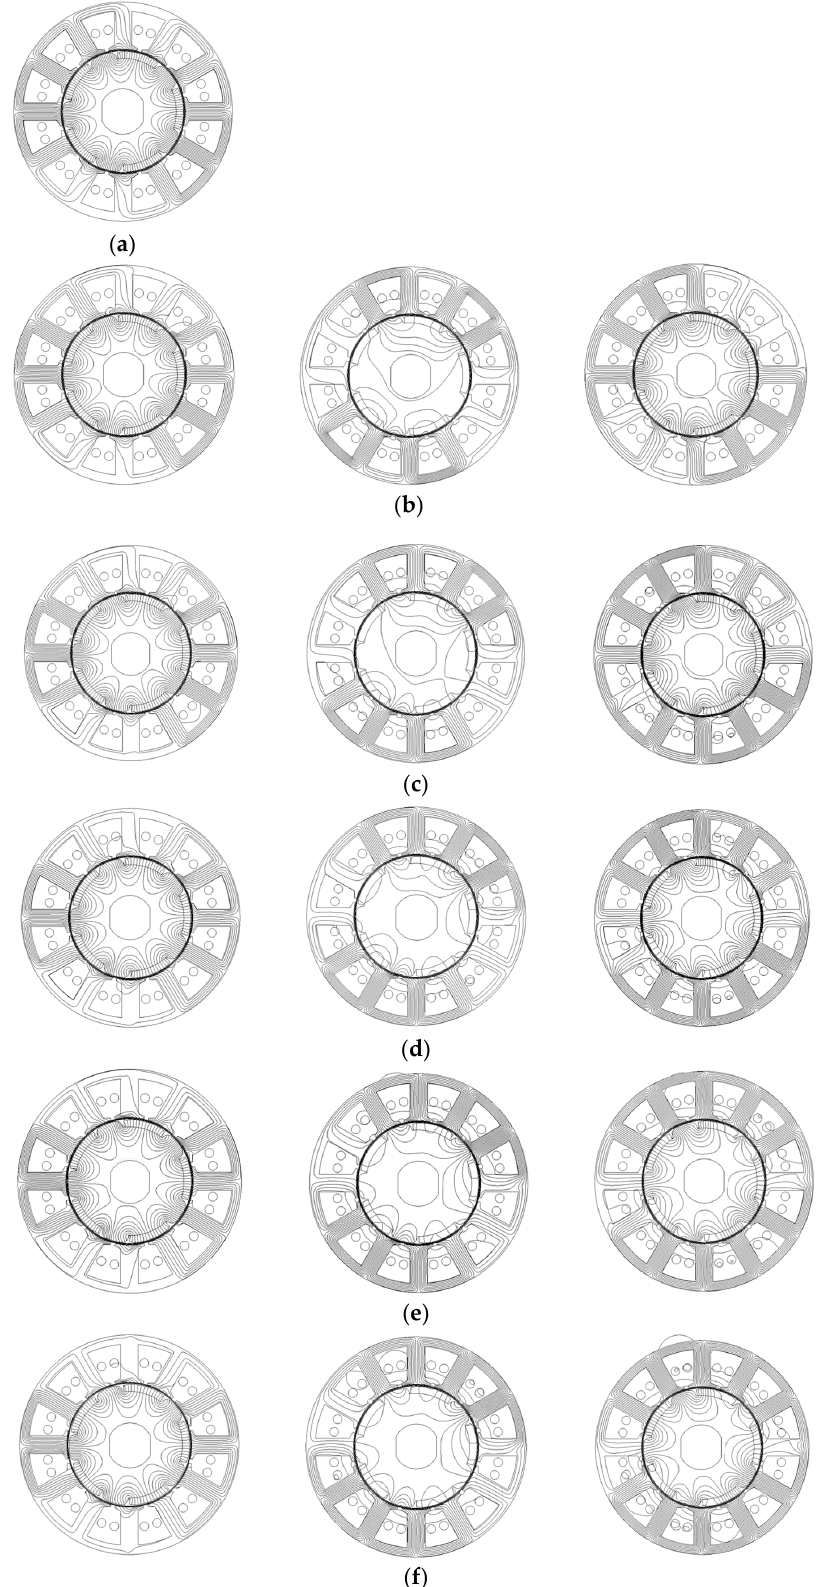
Figure 27. Equal potential distributions for 12s8p-PSCPPM. (from left to right: PM only, armature current only, overall) ( a ) 0A. ( b ) 10A ( c ) 20A. ( d ) 30A. ( e ) 40A. ( f ) 50A.